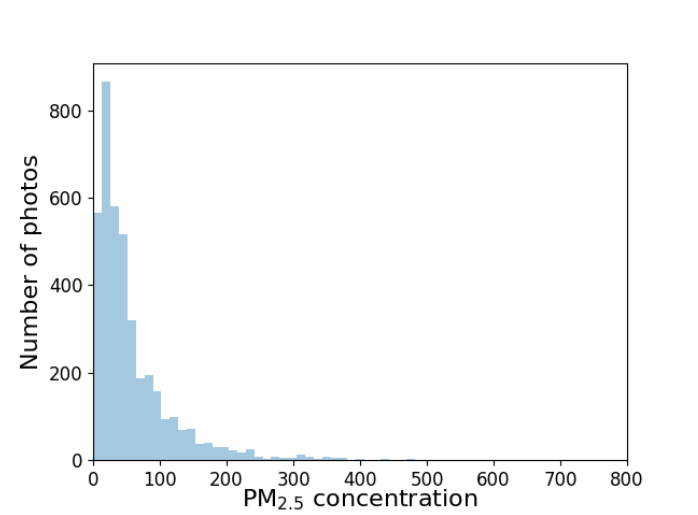
Figure 5. Histogram of PM 2.5 concentrations of the PPCP dataset.